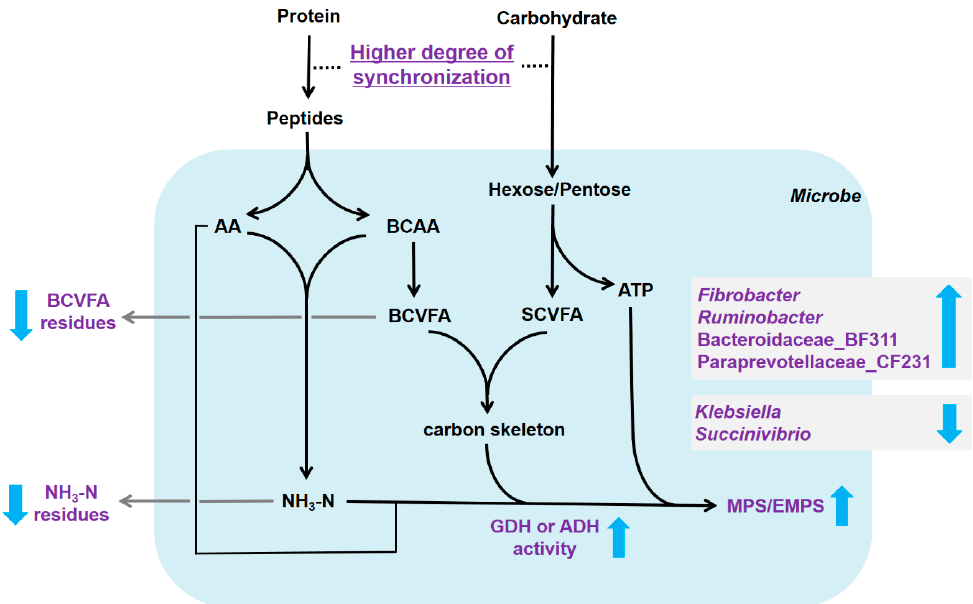
Figure 9. Diagram of how synchrony in the release of energy and protein influences the microbial synthesis pathways. The Cambridge blue area indicates the intracellular pathways of rumen bacteria. The light purples components indicate significant changes in our study, and the sideward arrows mean increased or decreased. AA, amino acids; ADH, alanine dehydrogenase; ATP, adenosine triphosphate; BCAA, branched-chain amino acids; BCVFA, branched-chain volatile fatty acids; GDH, glutamate dehydrogenase; MPS, microbial protein synthesis; EMPS, efficiency of microbial protein synthesis; SCFA, short-chain fatty acids.